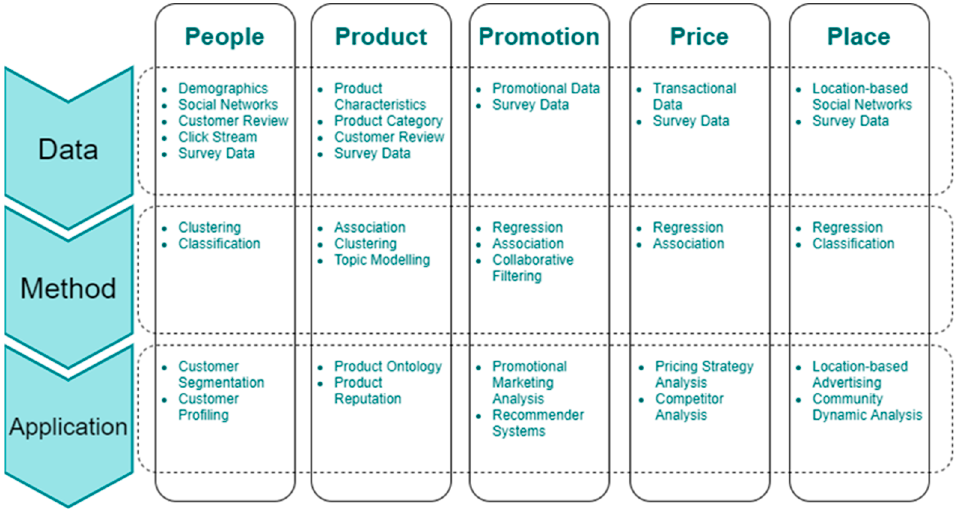
Figure 3. The marketing mix framework for big data management. Source: Fan et al. [97].